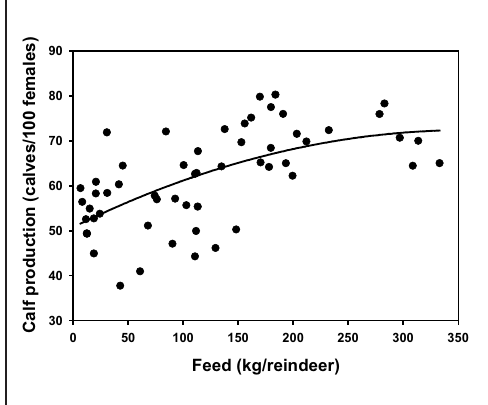
2. Dependence of the average calf production in the period 1993-99 on the amount of feed used per reindeer in the Finnish reindeer management area